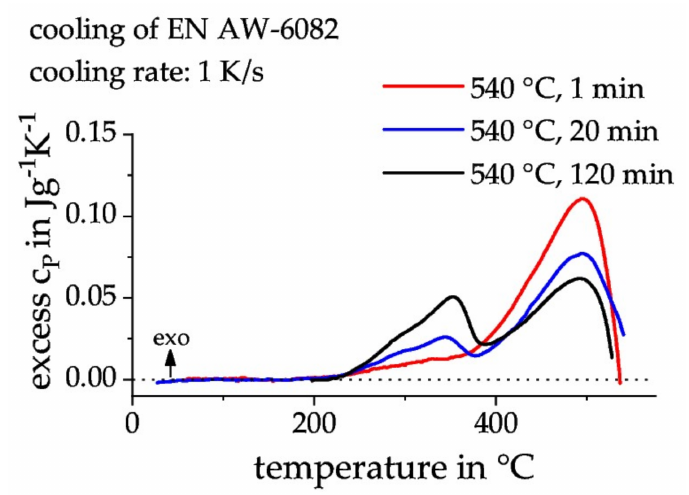
Figure 7. DSC cooling experiments on EN AW-6082 after solution treatment at 540 ◦ C, soaking times of 1, 20, and 120 min, and a cooling rate of 1 K/s.